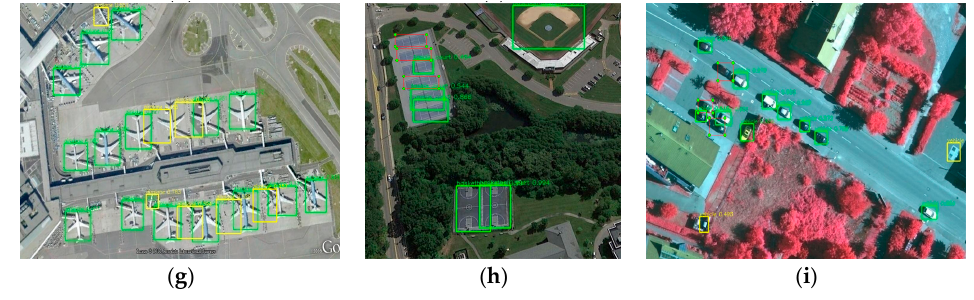
Figure 6. Detection results using our method, Faster R-CNN and SSD. The first row are results of our method; the second row are results of Faster R-CNN; the third row are results of SSD.